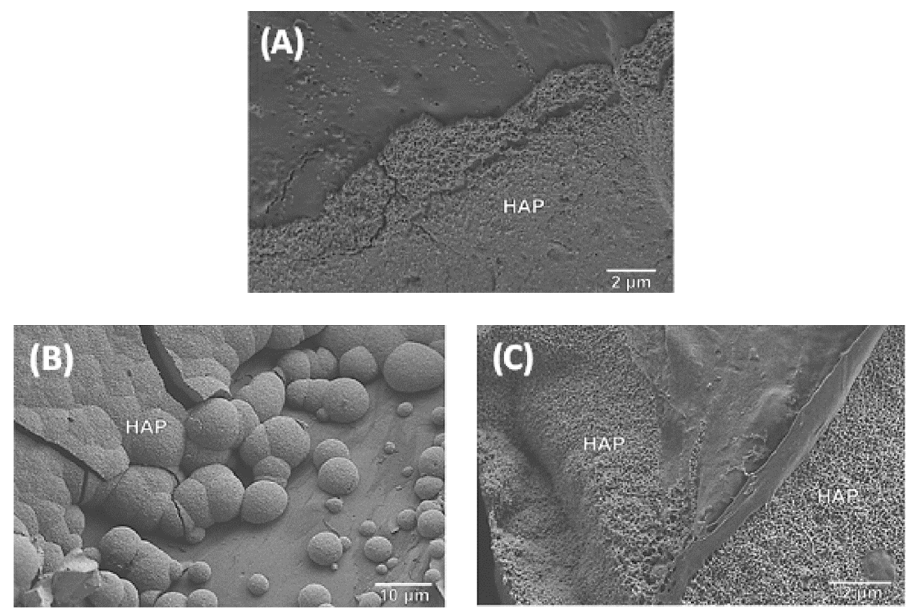
Figure 14. SEM images of biocomposites: ( A ) PDLA10BG 3.5 µm T3 after three days in SBF; ( B ) PDLA50BG 0.04–0.5 mm NT after seven days in SBF; ( C ) PDLA50BG 0.04–0.5 mm T3 after 7 days in SBF.